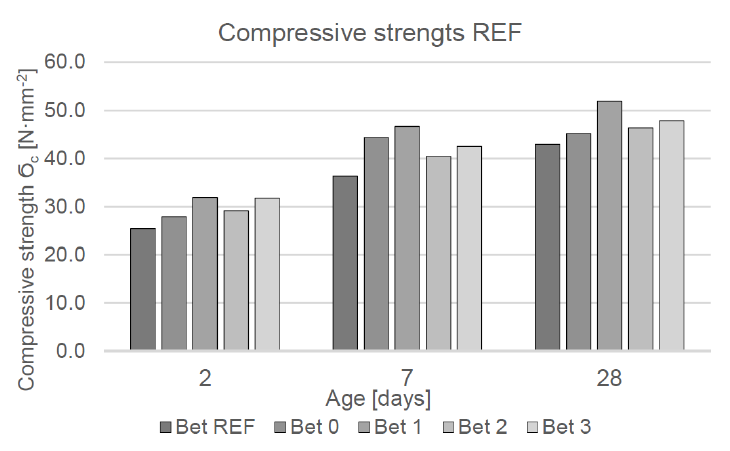
Figure 1. Compressive strengths of reference mix-design.